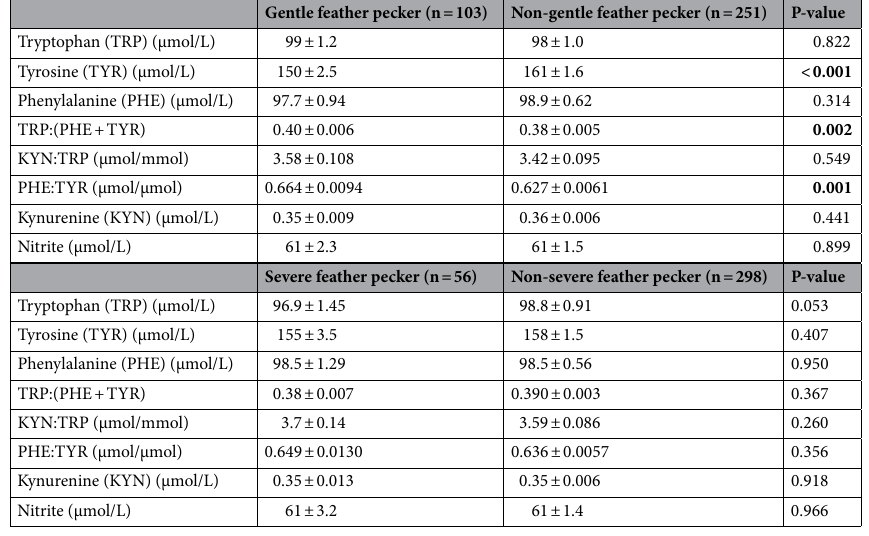
Table 4. Least Squares Means (± Standard Error) of the aromatic amino acids, kynurenine, and nitrite in birds at 14 weeks of age according to their feather pecking phenotype (feather pecker: bird that displayed gentle or severe feather pecking at least once between 10–13 weeks of